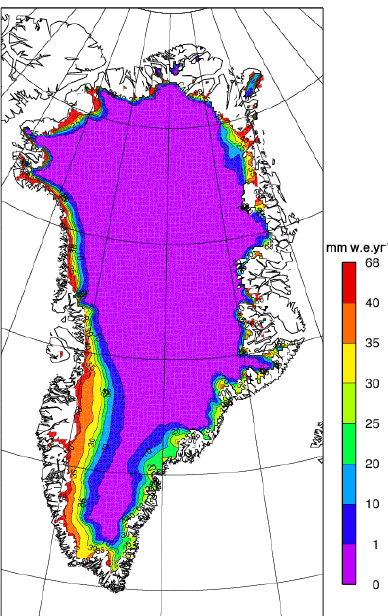
Fig. 12. Difference in refreezing when using different temper- ature descriptions (Wr2007–HdW1999 with d ice = 3m), using RACMO2 input